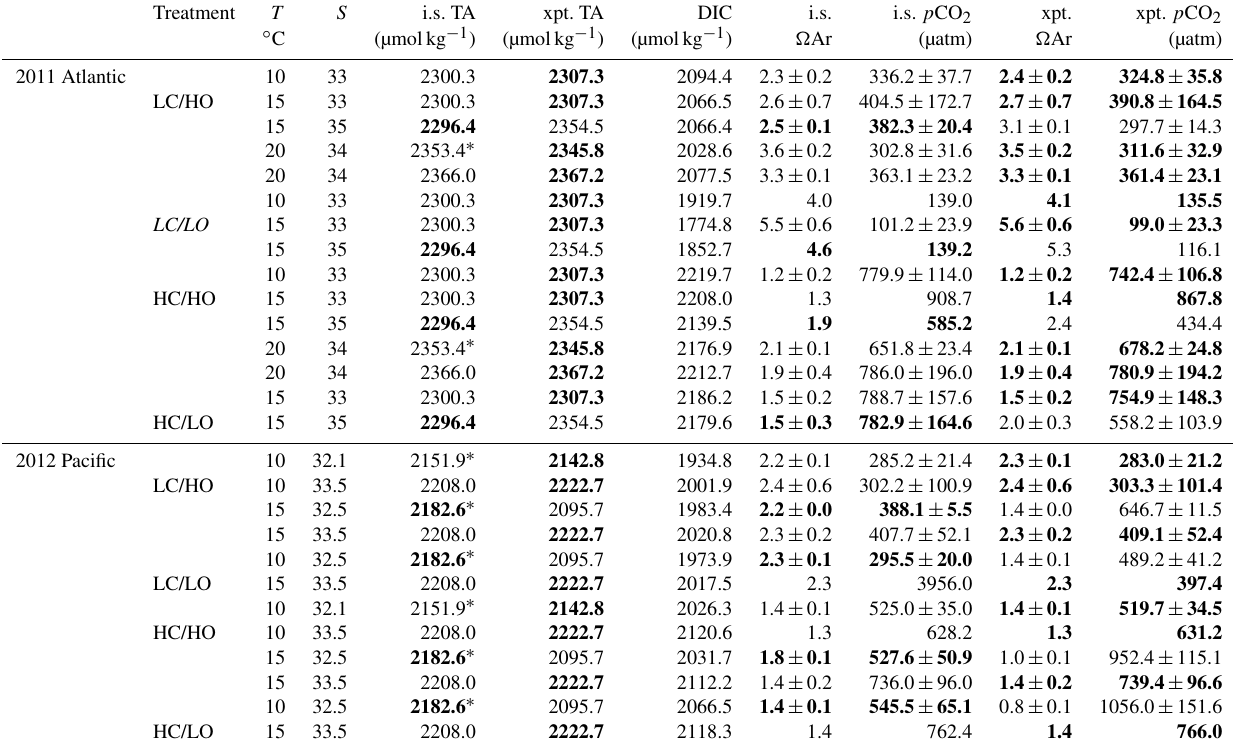
Table 3. Carbonate chemistry during manipulation experiments. The manipulation experiments were conducted at multiple temperatures ( T ) and salinities ( S ) based on the conditions the organisms were caught in. As described in more detail in the text, DIC measurements were made of water drawn from the control chambers while TA was measured for batches of experimental water (denoted as xpt. TA). In situ TA (i.s. TA), based on nearby CTD bottle sampling at the surface, is also shown. At test stations conducted while in transit to/from the main study regions, where bottle samples of in situ TA were unavailable, underway p CO 2 values and the LC/HO DIC were used to calculate in situ TA (denoted with ∗ ). In some instances, measurements of experimental TA differed by >20µmolkg − 1 from nearby in situ measurements of surface TA. This difference greatly exceeds expected variability based on measurement uncertainty and spatial (geographic and vertical) offsets in the locations of experimental water collection relative to the nearest CTD cast; in these circumstances, the experimental TA was likely erroneous due to sampling issues (e.g., contamination). For completeness, and to aid in identification of erroneous experimental TA values, calculations of carbonate chemistry parameters, including aragonite saturation state ( (cid:127) Ar ) and p CO 2 were made based on DIC and both experimental TA and in situ TA. In further data analysis and interpretation, calculations based on experimental TA are given preference except those few instances where experimental TA differed from in situ by >20µmolkg − 1 (bold denotes preferred calculations). Calculated saturation state and p CO 2 are reported as the average and standard deviation per batch of water. Note that the LC/LO gas tank in 2011 (in italics) appears to have been improperly mixed by the manufacturer as calculations suggested it contained a much lower CO 2 level than the intended 380µatm; it should consequently be considered an entirely separate treatment from the 2011 LC/HO (where CO 2 levels were based on bubbling with an ambient air